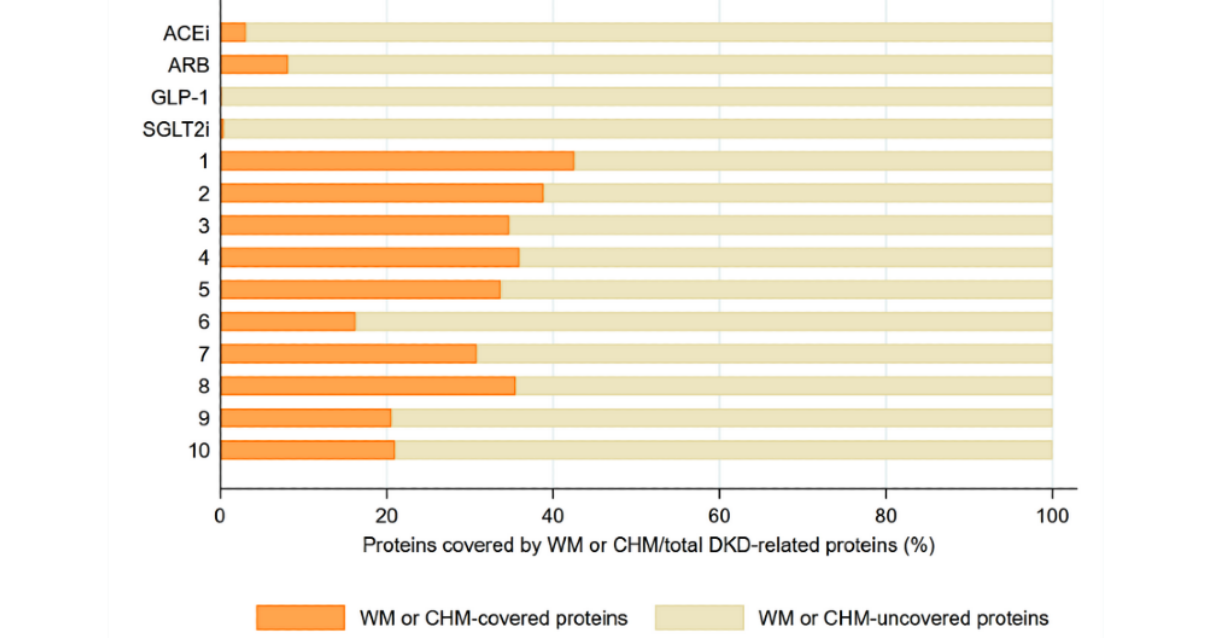
Figure 5. The proportion of DKD-related proteins covered by WM and CHM. A higher proportion of DKD-related proteins is covered by CHM clusters. ACEi: angiotensin-converting enzyme inhibitor; ARB: angiotensin receptor blocker; CHM: Chinese herbal medicine; DKD: diabetic kidney disease;